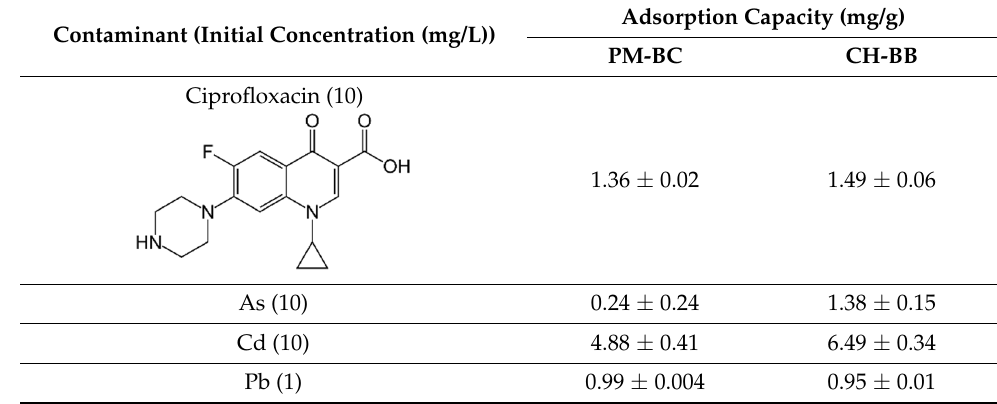
Table 2. Adsorption capacity of the tested adsorbents, pH 6.0, 150 rpm, 48 h. Contaminant (Initial Concentration (mg/L))